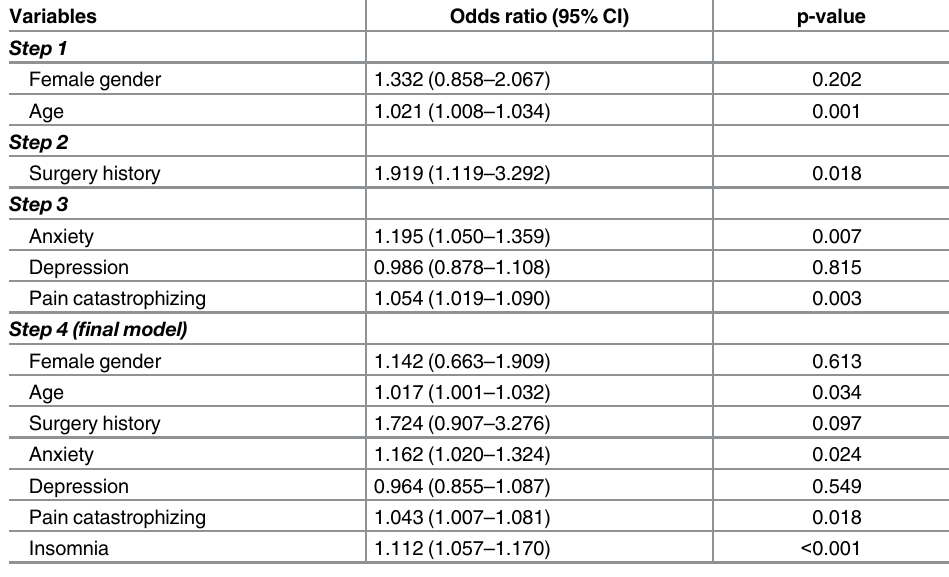
Table 2. Hierarchical multivariate logistic regression analysis for risk factors predicting severe pain (NRS (cid:1) 7, n = 172) in 357 chronic musculoskeletal pain